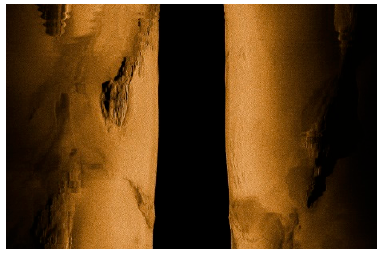
Figure 2. Original side-scan sonar image.